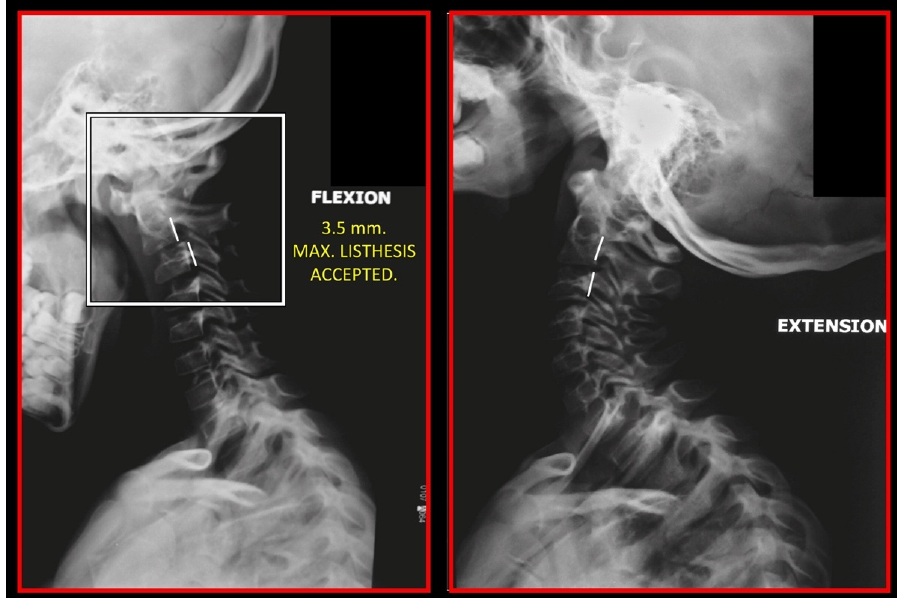
Figure 10. Static atlas on the occiput in flexion and extension. Additionally, notice the double ring of posterior arch of the atlas showing that it is also rotated and static. A 3.5-mm anterior listhesis of the axis on C3 during flexion. Lateral cephalometric study.